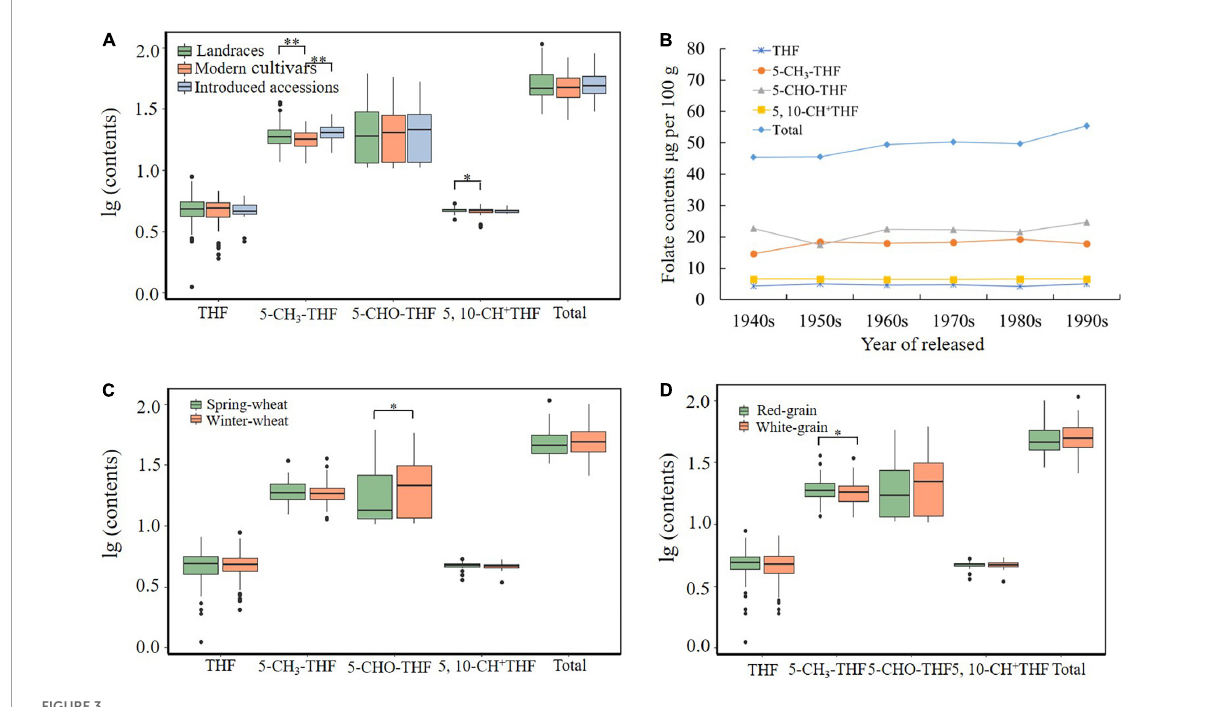
FIGURE3 Total folate and derivatives contents affected by accession types (A) , released years (landraces not included) (B) , winter/spring types (C) , and grain colors (D) . * and ** indicate significant differences at 0.05 and 0.01 levels, respectively.